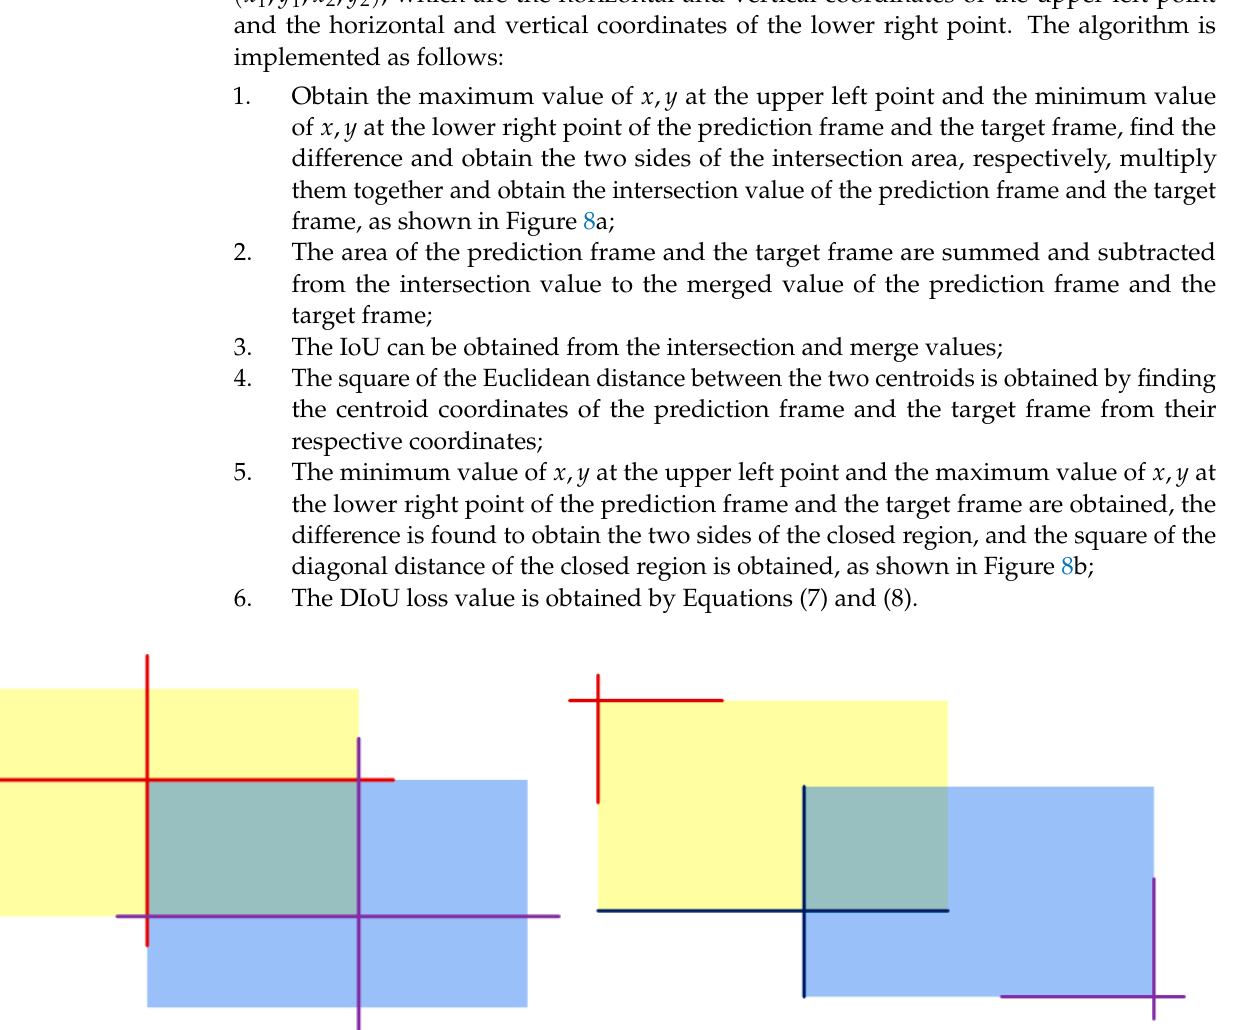
Algorithm 2: DIoU loss function forward